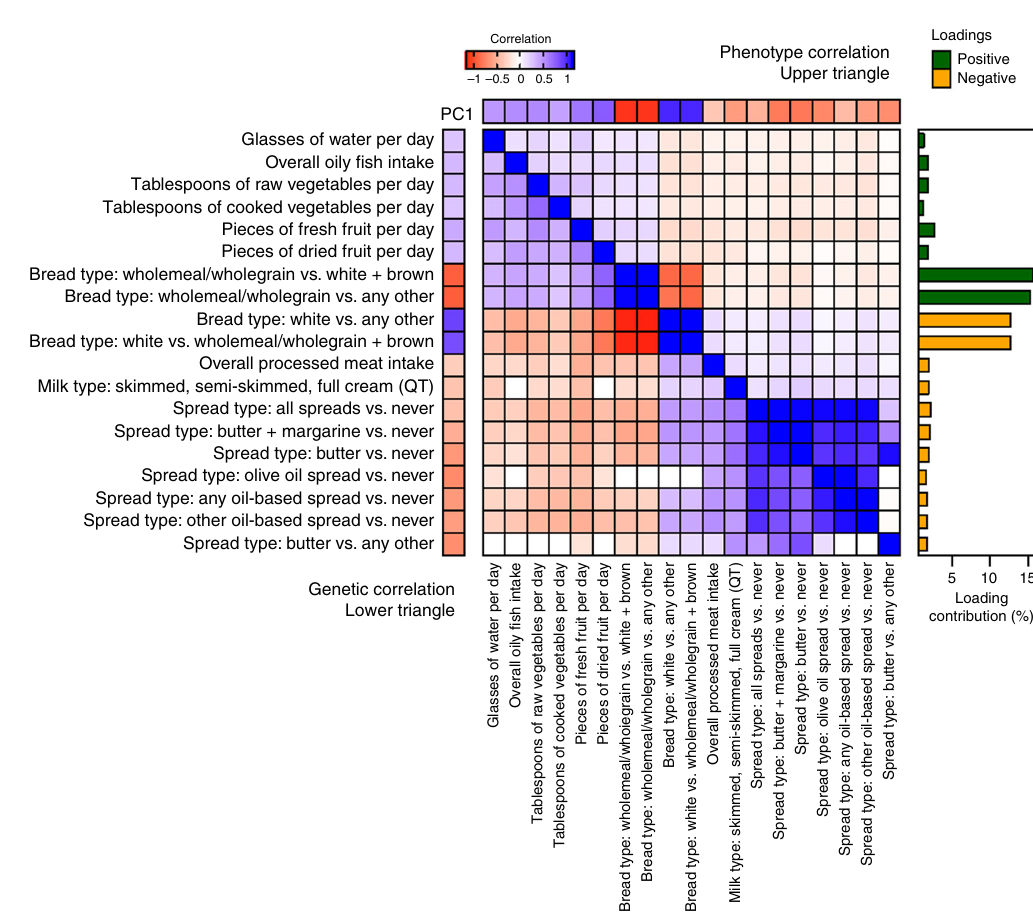
Fig. 1 Relationships between PC1 and its 19 signi fi cantly contributing single food intake QT. The heat map depicts the phenotypic (upper triangle) and genetic (lower triangle) correlation between the 19 signi fi cantly contributing single FI-QTs with each other and PC1. All correlations with nonsigni fi cant P values ( P > 0.05/85) were set to 0. Percent contribution of each of the 19 traits to PC1 is depicted in the correlation matrix bar plot annotation on the right, colored by loading